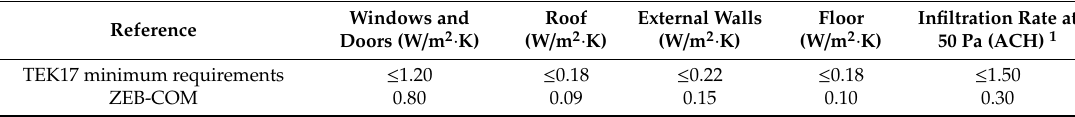
Table 2. TEK17 energy e ffi ciency requirements and ZEB Lab values.